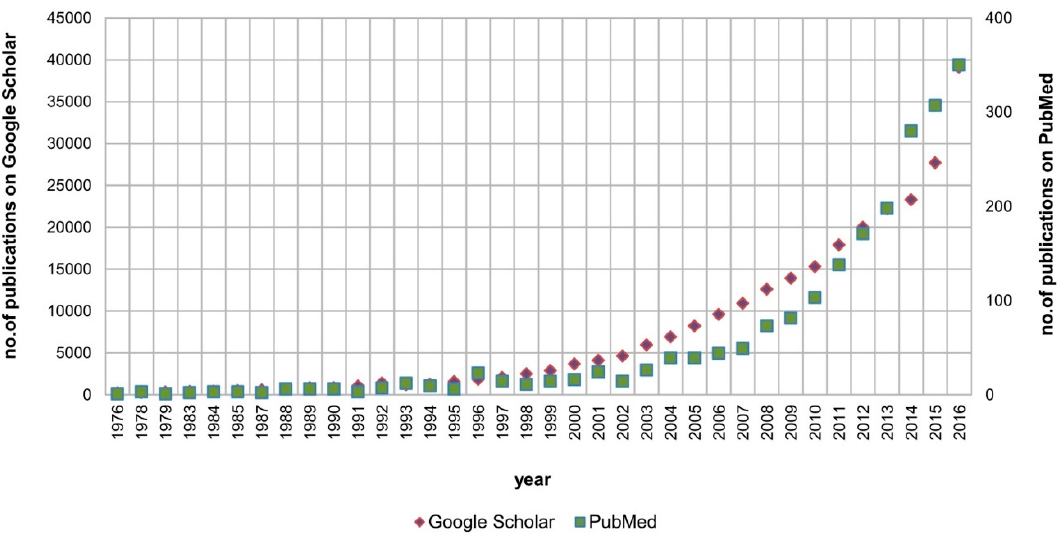
Figure 1. The annual number of publications found using PubMed and Google Scholar on the subject of gait monitoring using smart shoes. The search criteria included “(gait OR shoe OR walking) AND (inertial OR IMU OR sensor OR wearable)”; IMU: Inertial Measurement Unit.